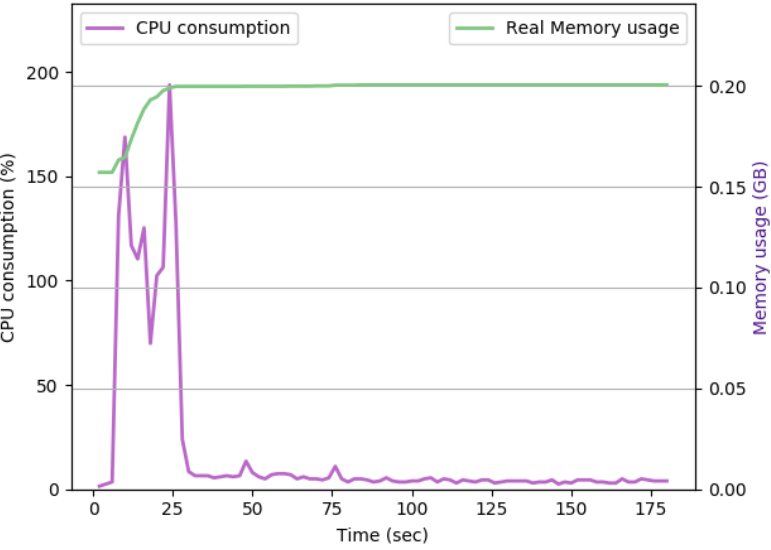
The CPU and memory utilization of the Raspberry Pi device